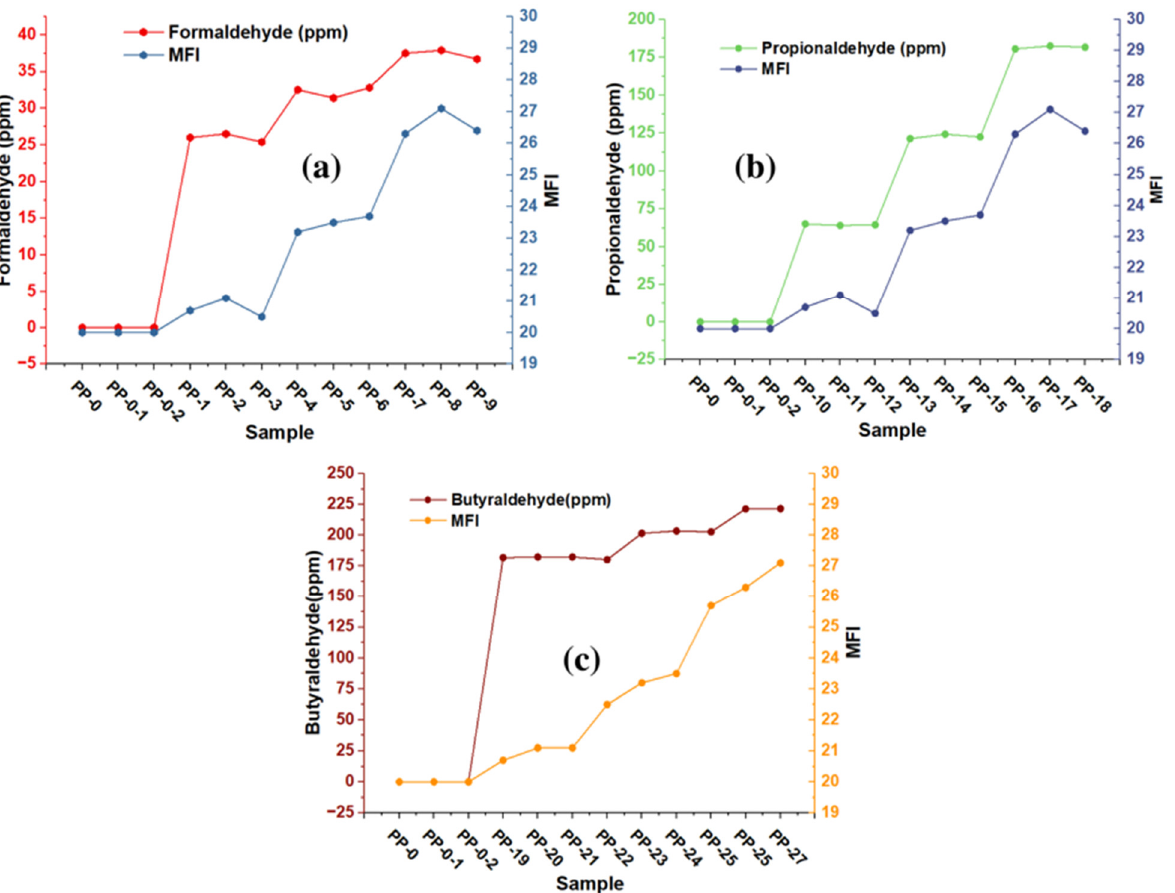
Figure 4. Effect of trace formaldehyde ( a ), propionaldehyde ( b ), and butyraldehyde ( c ) on the MFI of the copolymer.